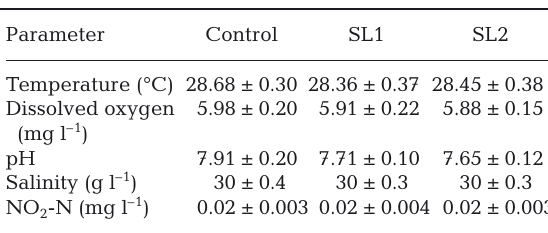
Table 2. Water quality parameters (mean ± SD) recorded in treatment and control aquaria with juveniles of Litopenaeus vannamei during chronic exposure experiment (21 d of exposure) with chlorpyrifos. SL1 (2): sublethal concentration